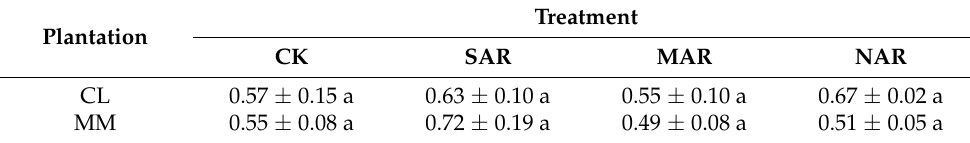
Figure 4. Variations in the annual mean soil respiration (Rs) ( a , b ), soil heterotrophic respiration (Rh) ( c , d ), and soil autotrophic respiration (Ra) ( e , f ) under different types of acid rain in Cunninghamia lanceolata (Lamb.) Hook. (CL) and Michelia macclurei Dandy (MM) plantations. Vertical bars represent standard errors ( n = 4). Means with different letters in common are significantly different ( p < 0.05). The absence of letters indicates no significant differences among acid rain treatments. Table 1. Effects of acid rain on the contribution of Rh to Rs (Rh/Rs) in Cunninghamia lanceolata (Lamb.) Hook. (CL) and Michelia macclurei Dandy (MM) plantations. Data are the mean ± standard error ( n = 4). Means followed by a common letter are not significantly different among different acid rain treatments ( p < 0.05).